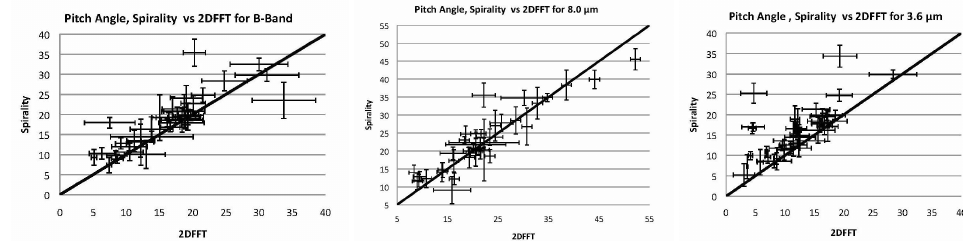
Figure 6. Spirality vs. 2DFFT measurements of 40 nearby spiral galaxies from Spitzer. Measurements were taken in three wavelength bands: 445 nm ( B -Band, left ), 3.6 µ m ( center ) and 8.0 µ m ( right ). In each panel, the diagonal line is y = x